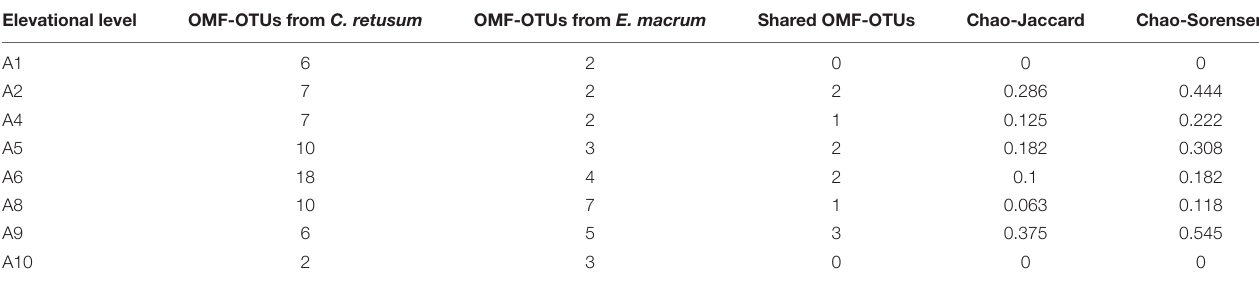
TABLE 1 | Number of orchid mycorrhizal fungi (OMF) OTUs and the similarity indices for the co-occurring orchids Cyrtochilum retusum and Epidendrum macrum at the different elevational levels (A1–A10). Elevational level OMF-OTUs from C. retusum OMF-OTUs from E.